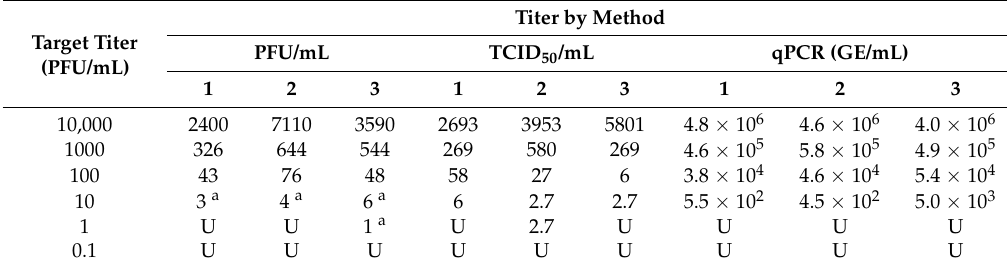
Table 1. Detection of EBOV/Mak isolate from sample dilutions using three titer methods. Target Titer (PFU/mL)